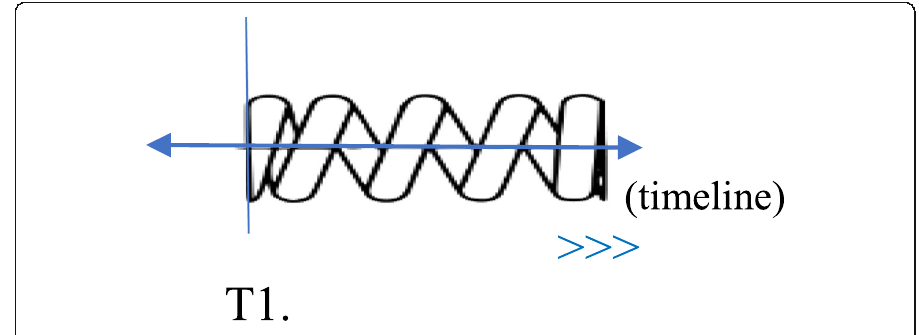
Fig. 9 The temporal characteristics of an open-ended process